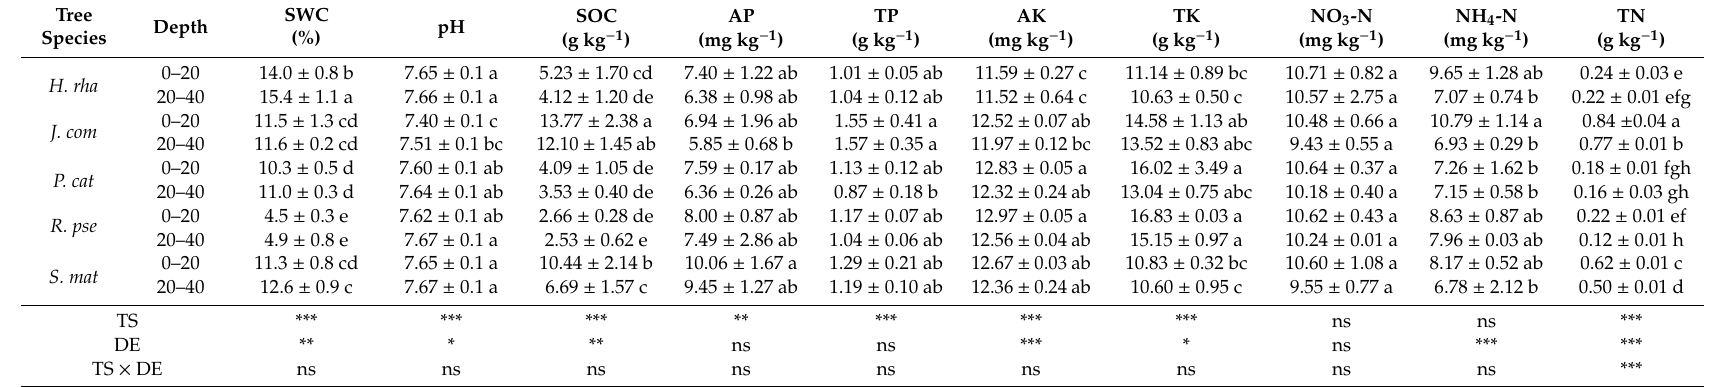
Table 1. Soil properties in the rhizosphere of five dominant tree species at two soil